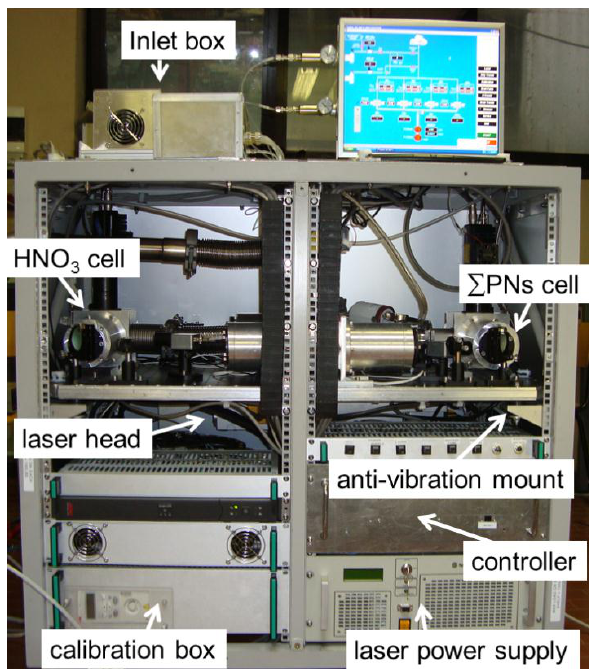
Fig. 2. A photograph of the TD-LIF installed in the rack for use Figure 2. A photograph of the TD-LIF installed in the rack for use on board the FAAM BAe 2 on board the FAAM BAe 146-301 research aircraft. The inlet box 146-301 research aircraft. The inlet box includes the quartz tubes with heater for thermal 3 includes the quartz tubes with heater for thermal dissociation of or- dissociation of organic nitrates and HNO 3 into NO 2 . 4 ganic nitrates and HNO 3 into NO 2 .